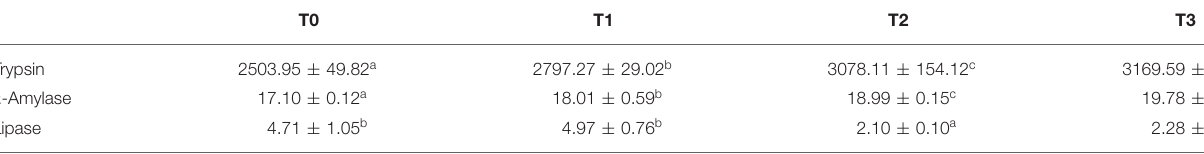
TABLE 8 | Hepatopancreas parameters of grass carp (means ± SD, n = 4). T0 T1 T2 T3 AST (U/mg)